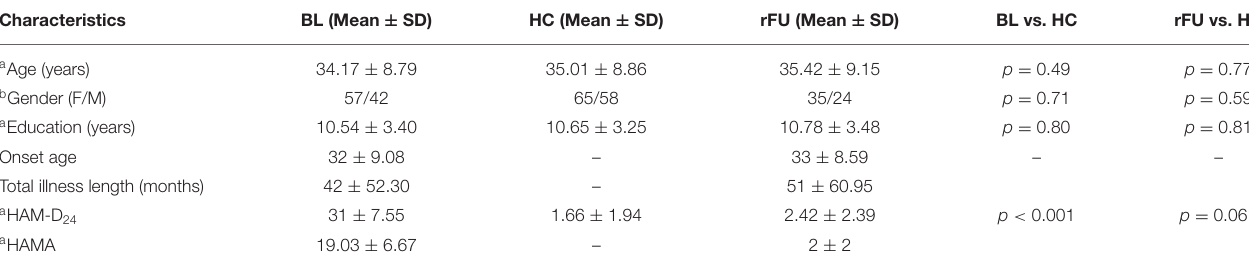
TABLE 1 | Demographic and clinical characteristics by groups.